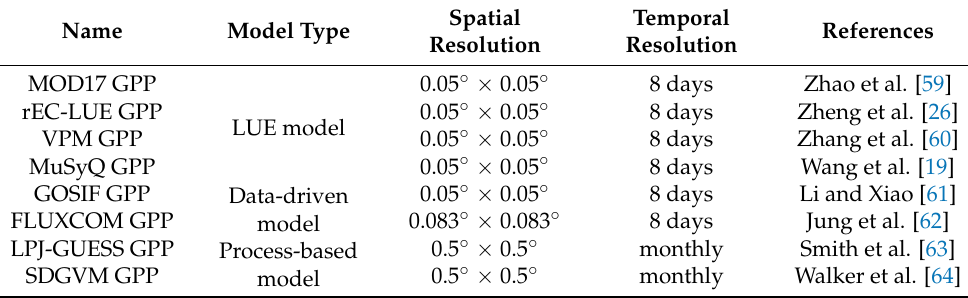
Table 1. Multiple GPP products selected for comparison in this